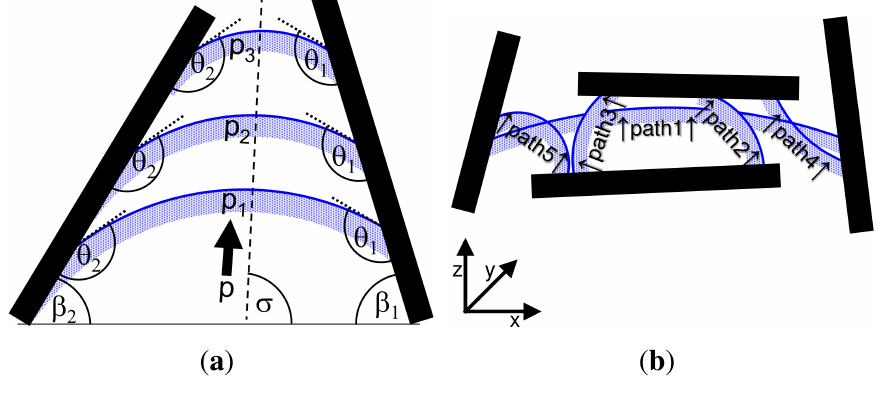
Figure 1. Illustration of the concept of the water path network: ( a ) a path consists of stable menisci positions between an object pair; ( b ) each point in space can be part of several paths having different entry pressures (menisci